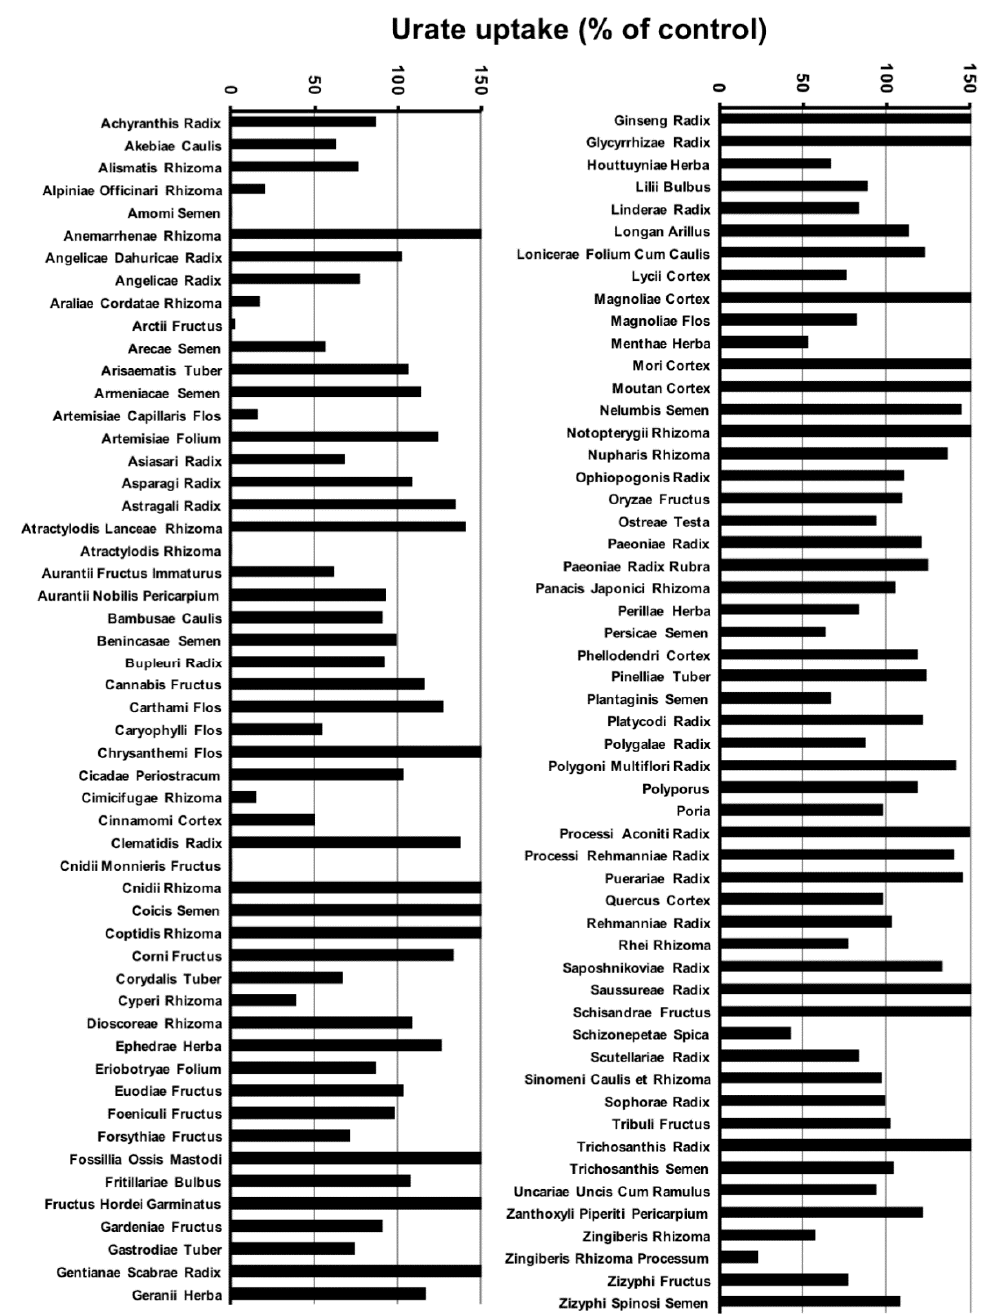
Figure 1. Effects of crude drug extracts on the uptake of uric acid via urate transporter 1 (URAT1). HEK293/PDZK1 cells were transiently transfected with human URAT1. The cells were incubated with uric acid (11.6 µM) with or without each crude drug extract (100 µg/mL) at 37 °C for 30 min, and the uptakes of uric acid into the cells were measured. The origins of crude drugs are listed in Supplementary Table S1. Data are expressed as % of control, calculated as described in Materials and Methods, and they represent averages of the experiments ( n = 2).